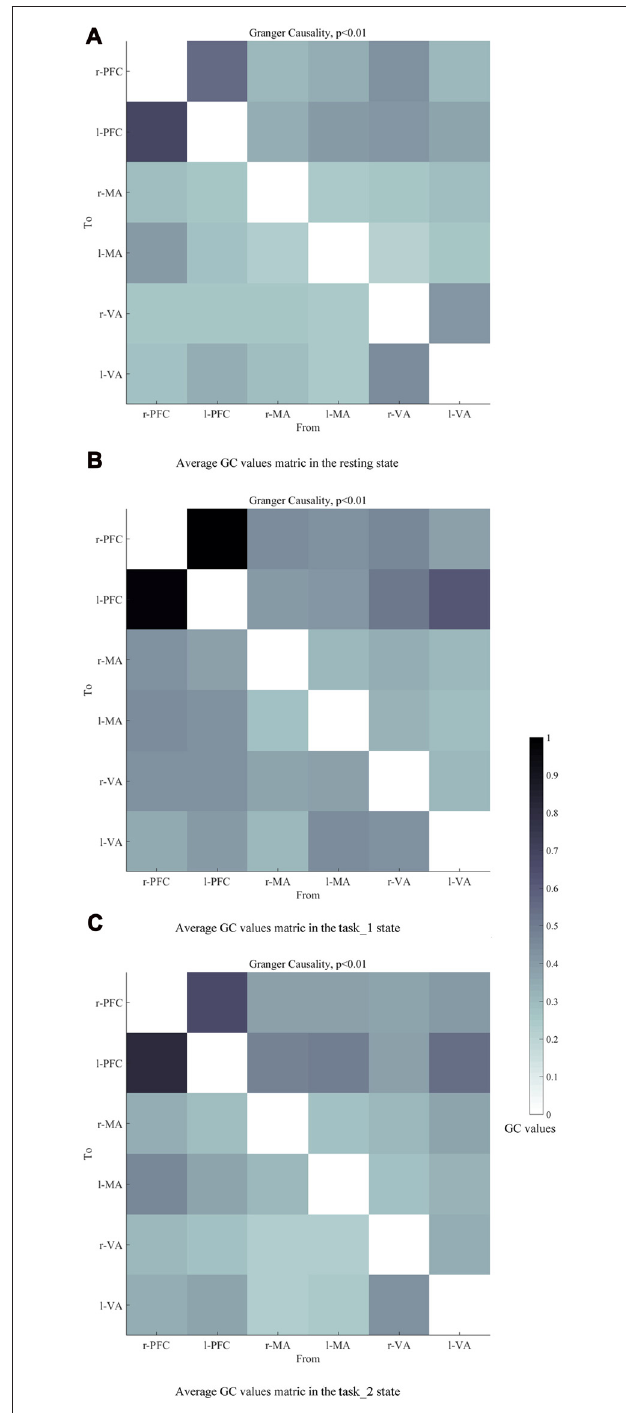
FIGURE 7 | Average GC value matrices of six brain areas in the (A) (resting), (B) (task_1) and (C) (task_2) states, respectively. Each element in the matrix denotes the average GC values across all subjects. The causal line is from bottom row to the left column. The darker color of the block represents the higher GC values of the connection. Abbreviations: r-PFC, right prefrontal cortex; l-PFC, left prefrontal cortex; r-MA, right motor-related areas; l-MA, right motor-related areas; r-VA, right vision-related areas; l-VA, left vision-related areas; GC, granger causality.